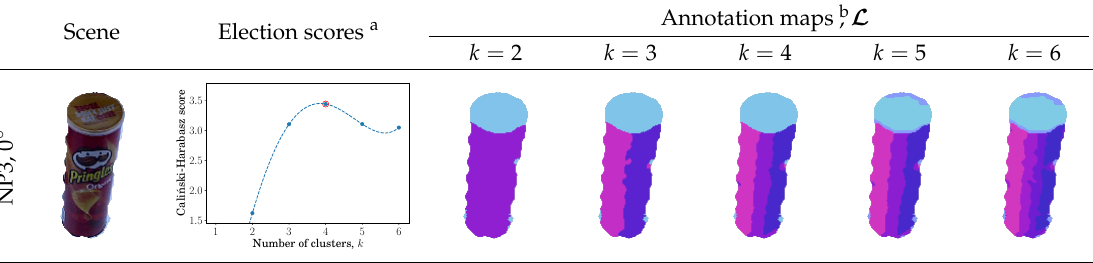
Figure 15. Although approximating curved surfaces as planar segments improves the viewpoint representation, some interesting points are split apart, which drastically affects their